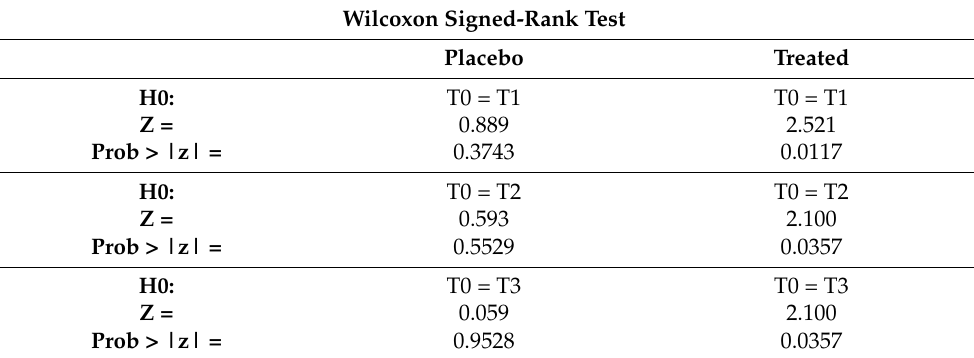
Table 3. Test results, non-parametric for dependent samples, signs of Wilcoxon ranks. Comparison of the responsiveness rate within each group over time in relation to